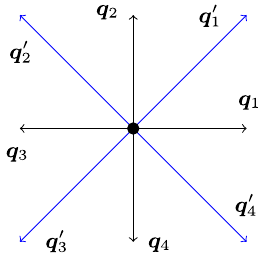
FIG. 11. Tunneling vectors for the simplified C4FB model Eq. (F2). The blue and black vectors correspond to the terms in the first and second row of Eq. (F2),